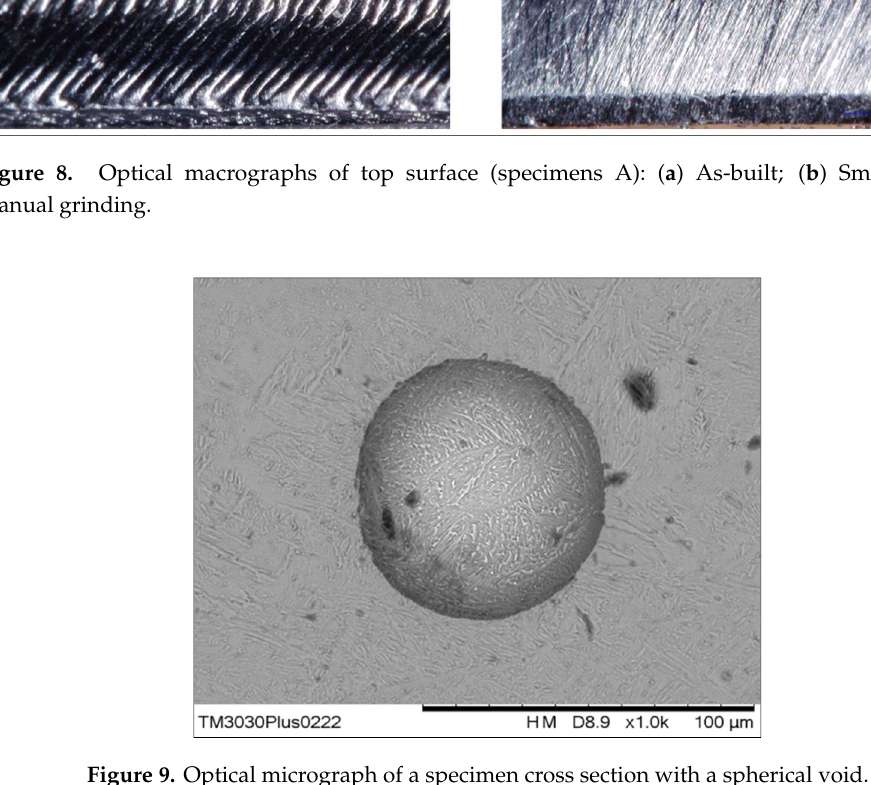
Figure 9. Optical micrograph of a specimen cross section with a spherical void.